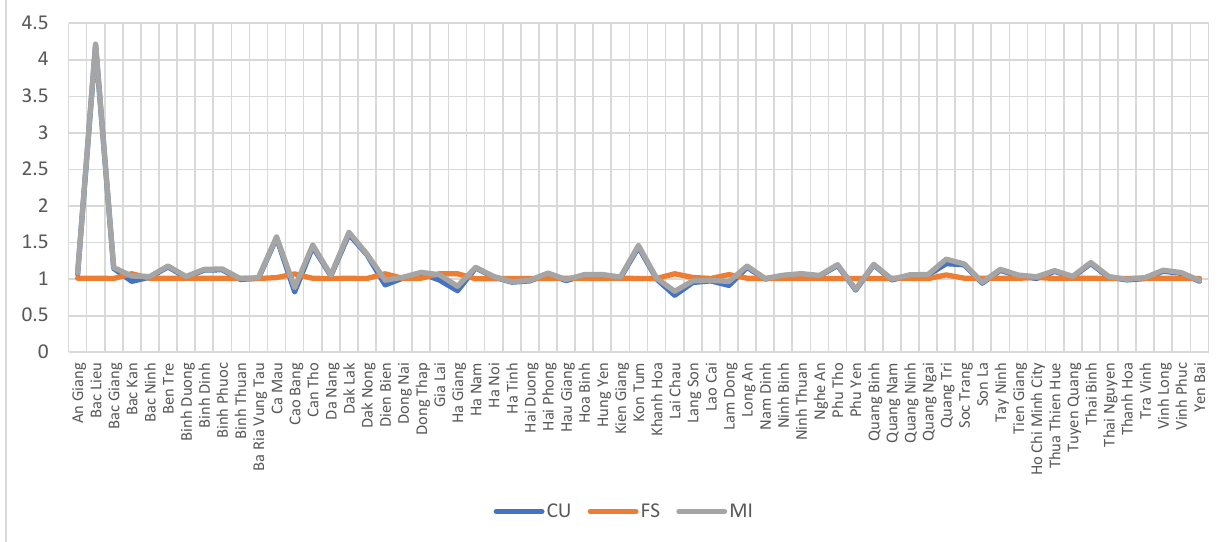
Figure 3. Comparison of catch-op (CU), frontier-shift (FS), and Malmquist index (MI).